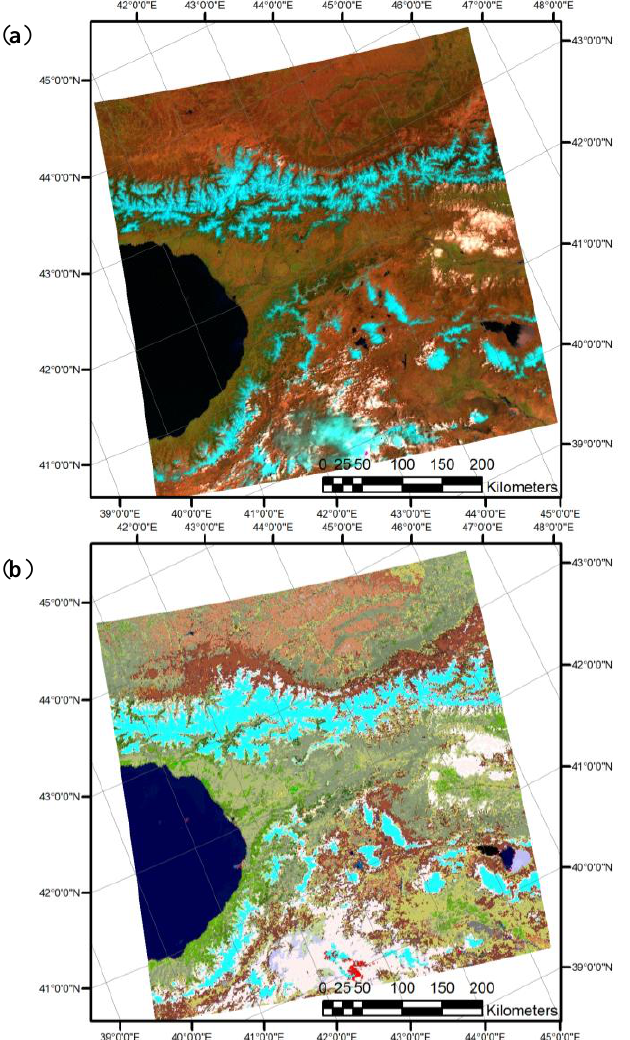
Output spectral categories are depicted in pseudo colors. Map legend: similar to Table